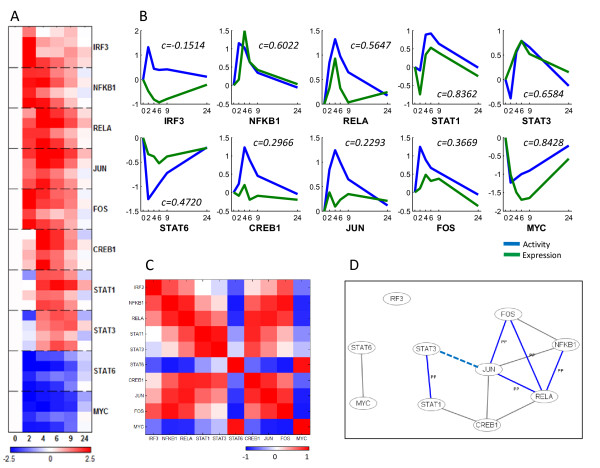
Transcription factor activities calculated using NCA. (A) Predicted activities of the ten transcription factors used in this study. For each transcription factor, rows represent progression in time and columns correspond to the four human subjects. Activities of each row are normalized to the zero time point. (B) Transcription factor activities (blue) compared to gene expression (green), with Pearson correlation coefficients noted. Both activity and expression at each time point are averages normalized to the time = 0 values, and the activity is further scaled for direct comparison with the expression values. (C) Correlation matrix between transcription factor activities. Red represents positive correlation, and blue represents negative correlation. (D) Inferred combinatorial regulation pairs of transcription factors. A blue solid line indicates that the pair was supported by protein-protein interaction knowledge of BIND and high correlation of their activities (>0.75). A black solid line indicates that the pair was only supported by high correlation, and a blue dotted line indicates that the pair was only supported by the interaction database.